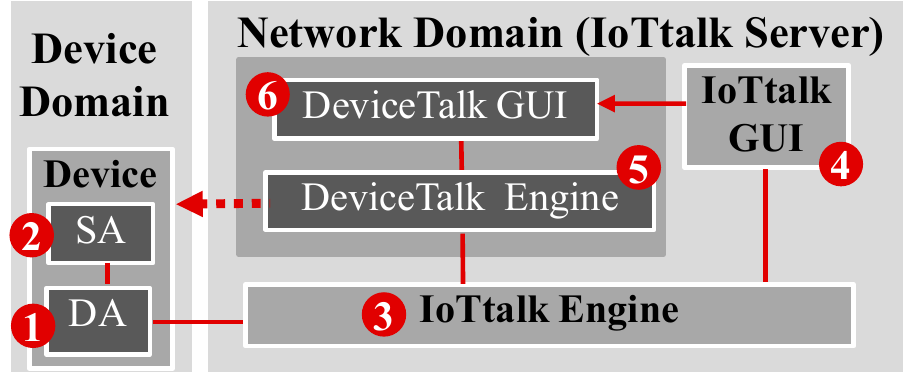
Figure 2. The DeviceTalk architecture for client–server-based intelligent distributed system.